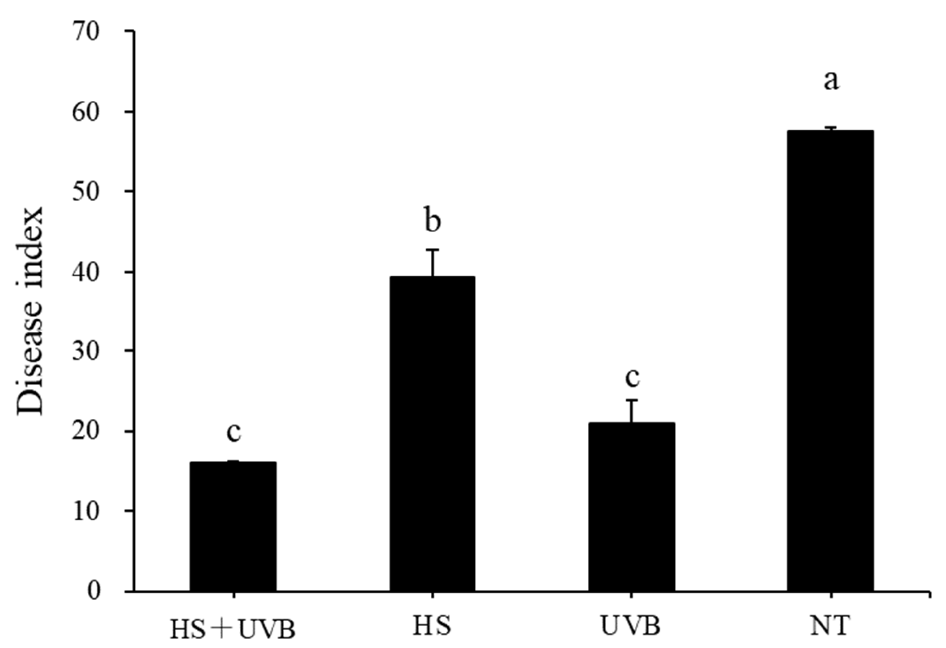
Figure 7. Preventive effects of UV-B, HS, and combined HST and UV-B against powdery mildew in cucumber. HS+UVB: combined UVB and HST; UVB: UVB treatment; HST: heat shock treatment; NT: no UVB or HST. All treatments were followed by inoculation with powdery mildew. The disease index is based on a 0–4 rating scale applied to the first leaf on each plant 33 d post-inoculation. Different letters above columns indicate a significant difference between treatments. Vertical bars represent the standard error of the mean ( n = 6; Tukey’s test, p < 0.05).